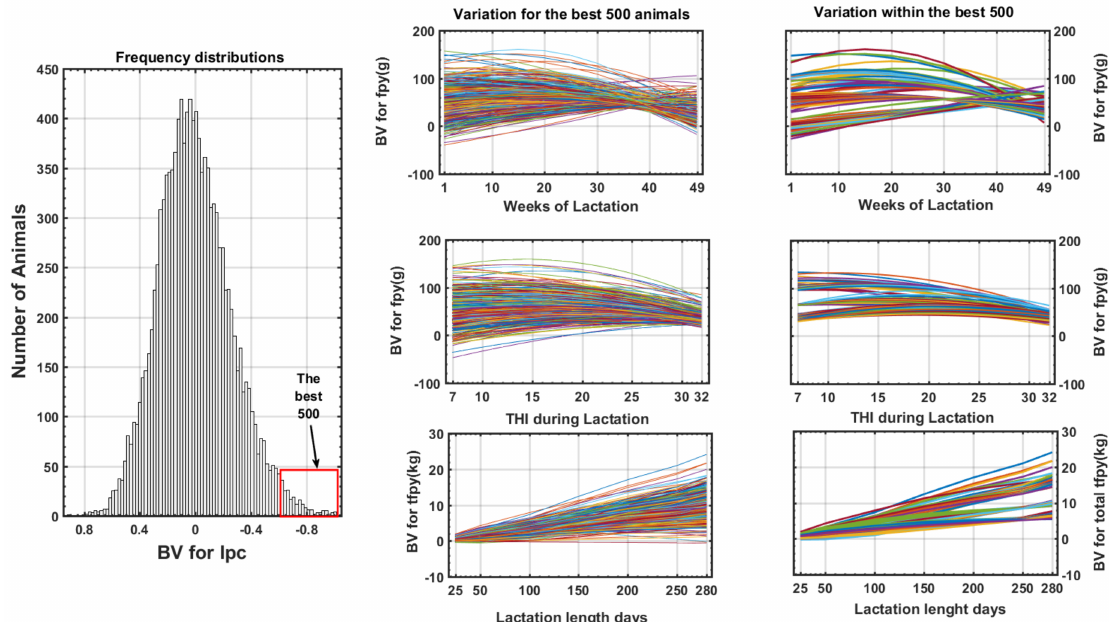
Figure 7. Frequency distributions of the new Ipc index ( left ) for Florida goats and variability of the best 500 animals for daily fpy ( right ) along DIM and THI and cumulate fpy at different point of lactation